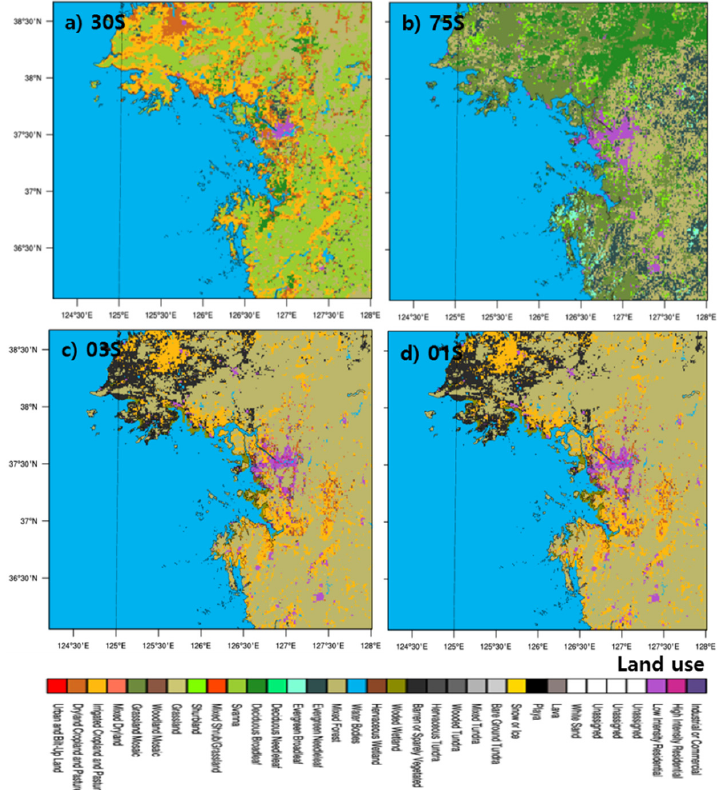
Figure 3. Distribution of surface land use in the inner domain for ( a ) Control; ( b ) 75S; ( c ) 03S; and ( d ) 01S. The colorbar represents land use type according to the Korea Land Cover 33 type system. The magenta/purple colors represent urban areas and other colors are for rural areas.